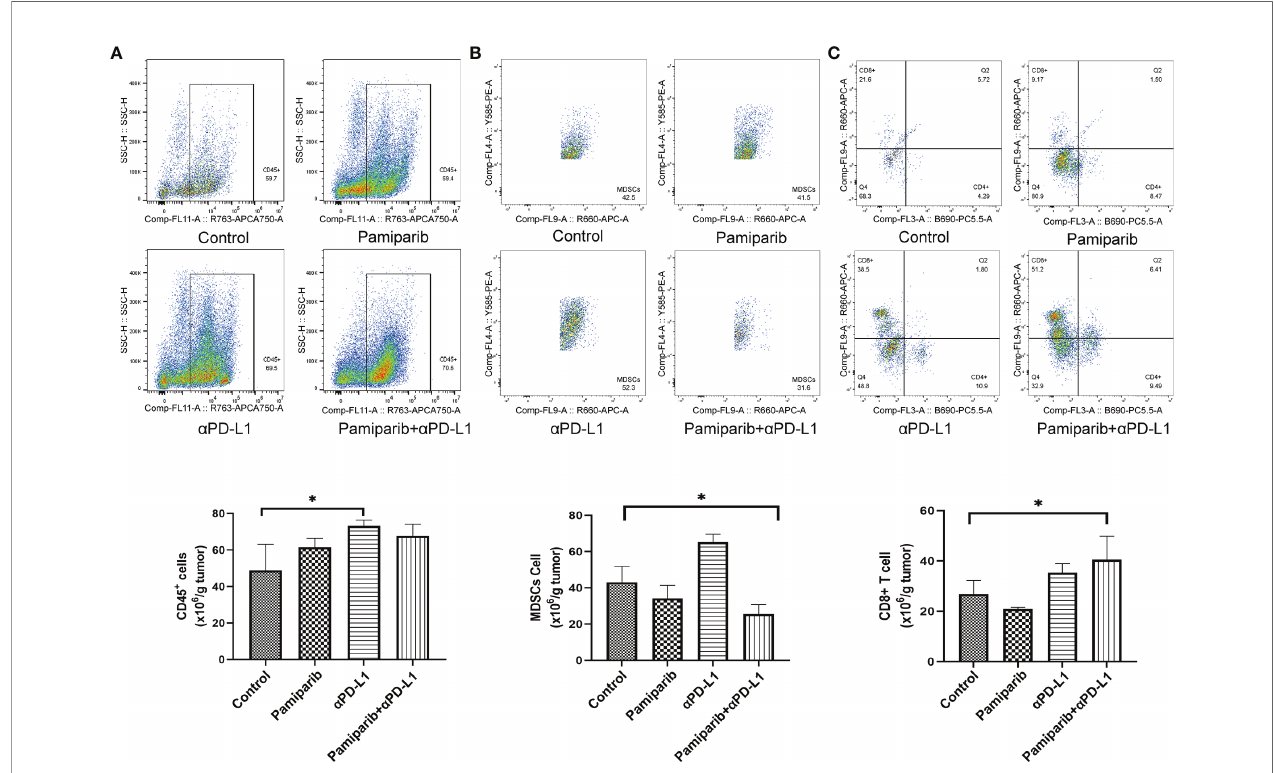
FIGURE 7 | Flow cytometry analysis con fi rms that combination therapy with pamiparib and PD-L1 blocker alters the immune microenvironment. (A – C) Flow cytometry analysis to calculate the ratio values of CD45 + cells (A) , MDSC cells (B) and CD8 + T cells (C) per 1.0 g of tumor tissue. * P <